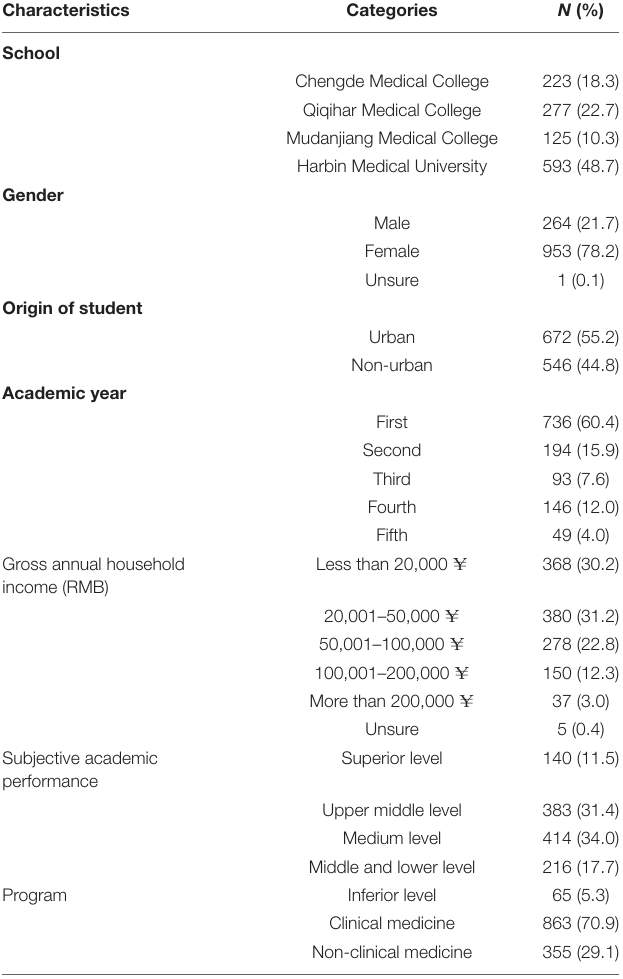
TABLE 1 | Characteristics of respondents ( N = 1,218).